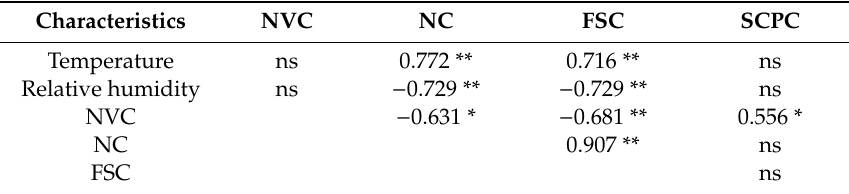
Table 2. Correlation coe ffi cients by Spearman between meteorological factor and nectar characteristics.